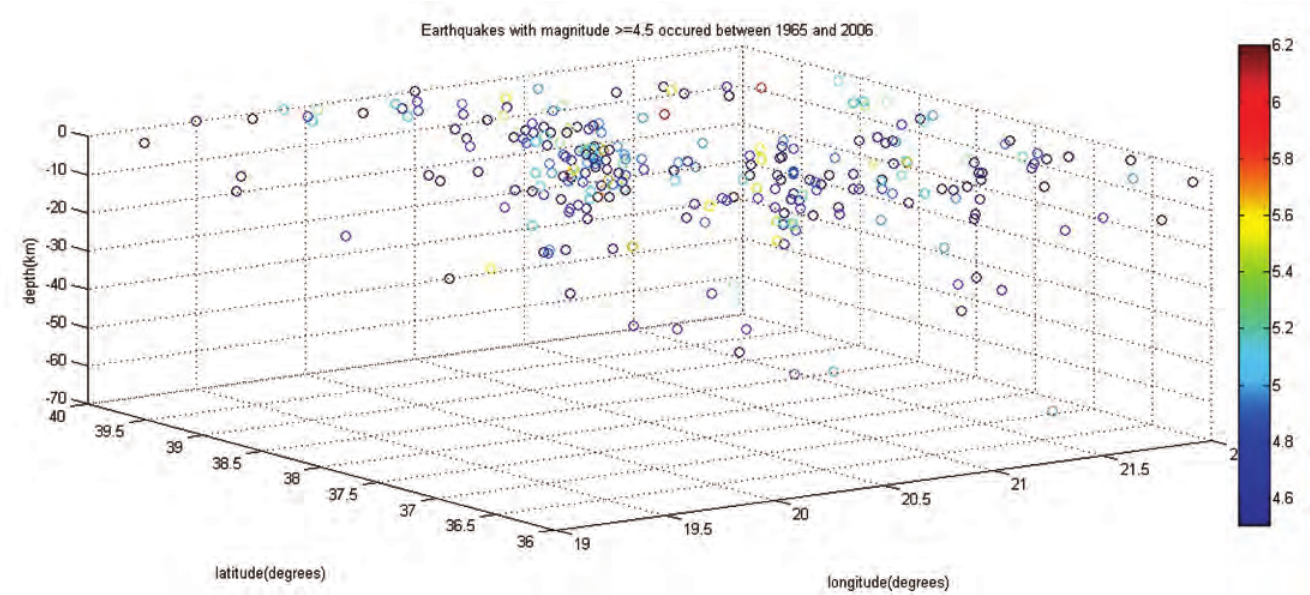
Figure 3. The space distribution of 278 earthquakes with magnitude $ 4.5 that occurred in the period from January 1964 to December 2006. Parameter Sofia (latitude 42.71˚)